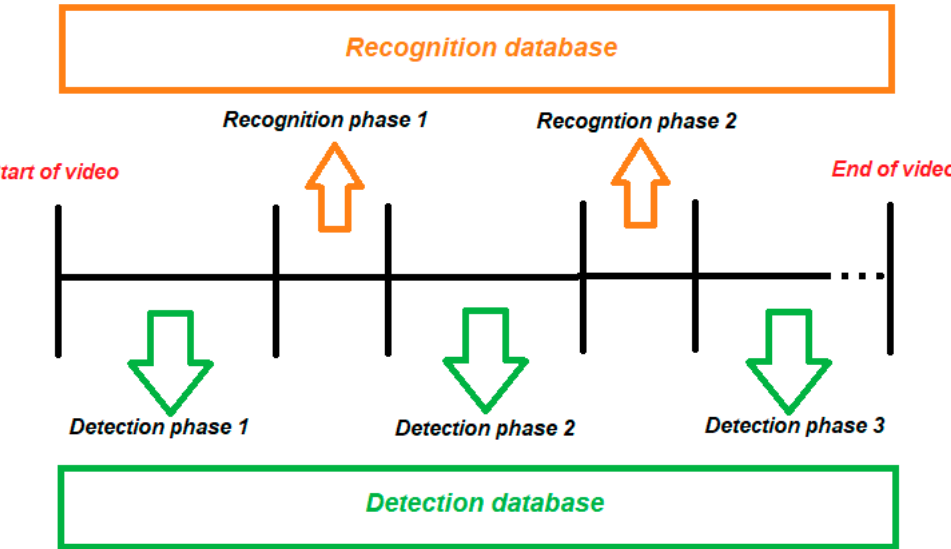
Figure 13. Detection and recognition phases combined.